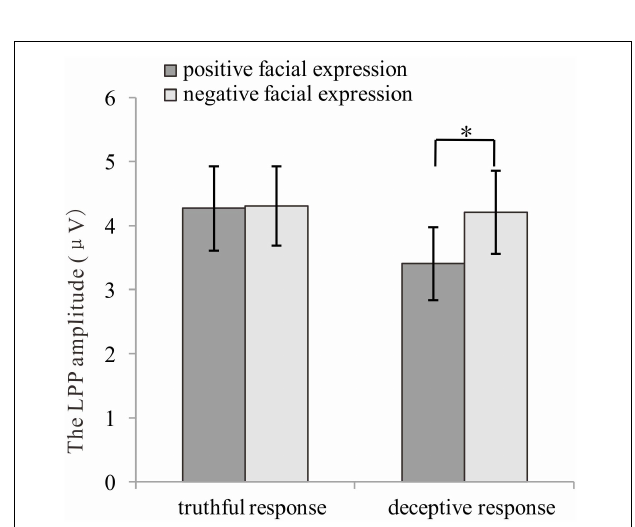
FIGURE 5 | The late P3 amplitudes for truthful and deceptive responses to positive and negative facial expressions. * p <